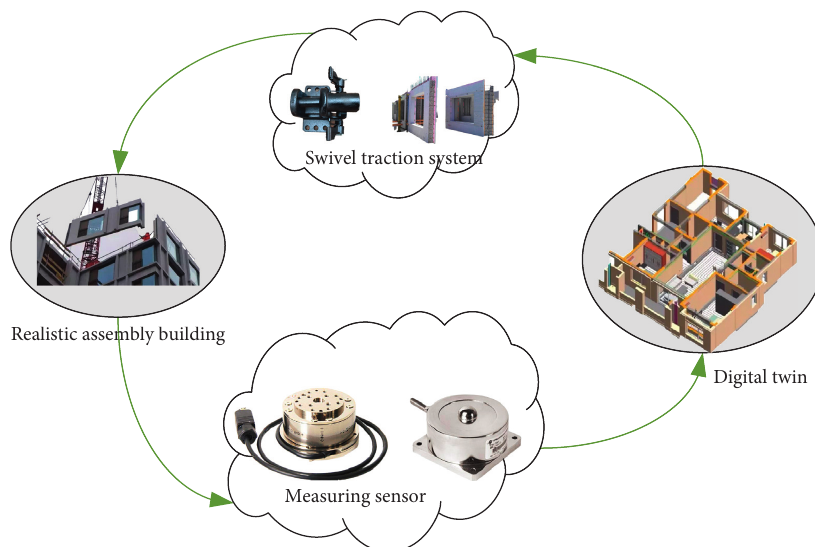
Figure 5: Measured and assembled building